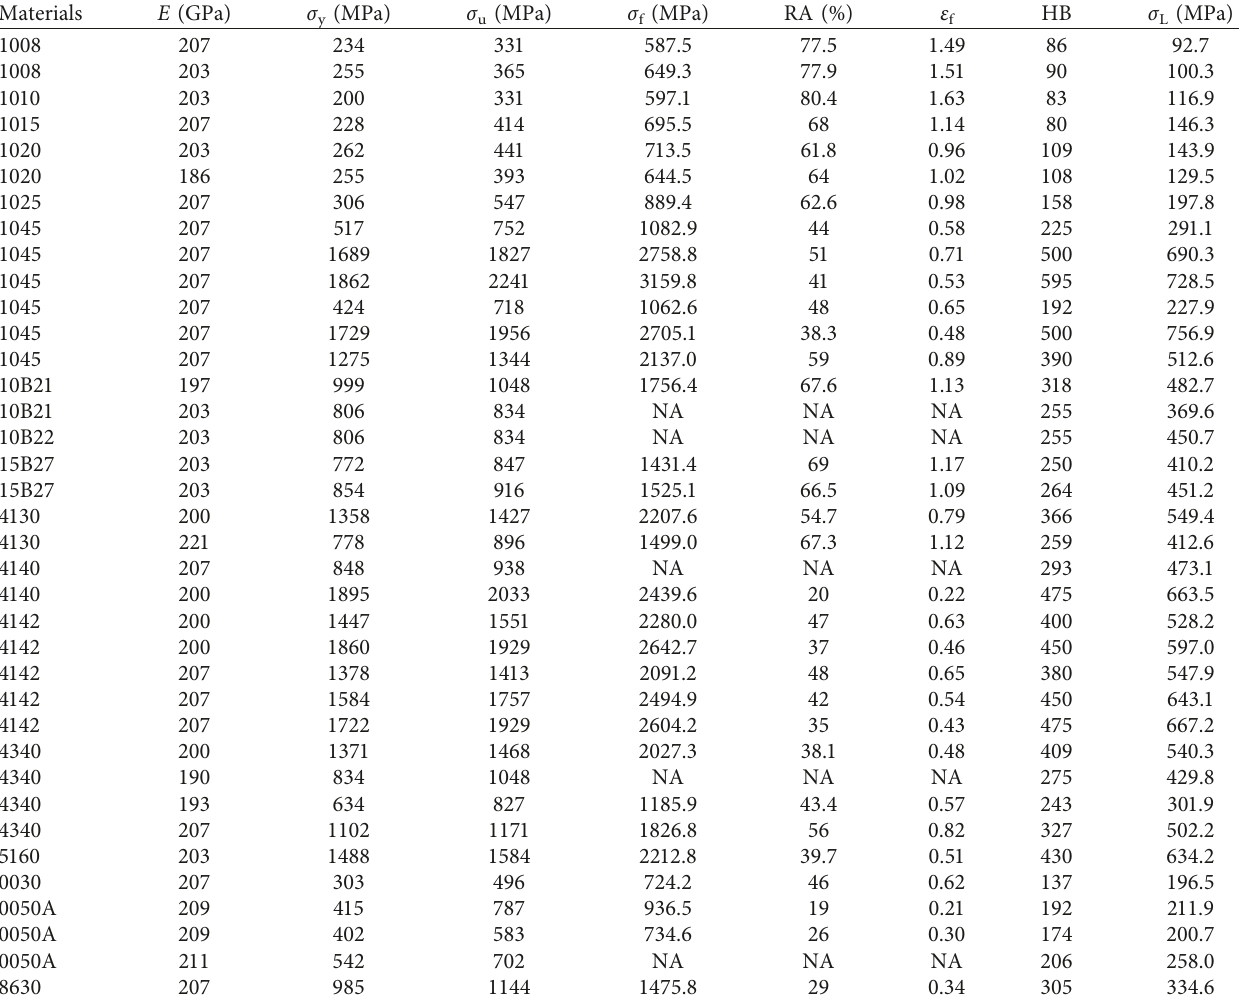
Table 3: Monotonic deformation properties and fatigue limit of the selected steels from SAE J1099 [8].